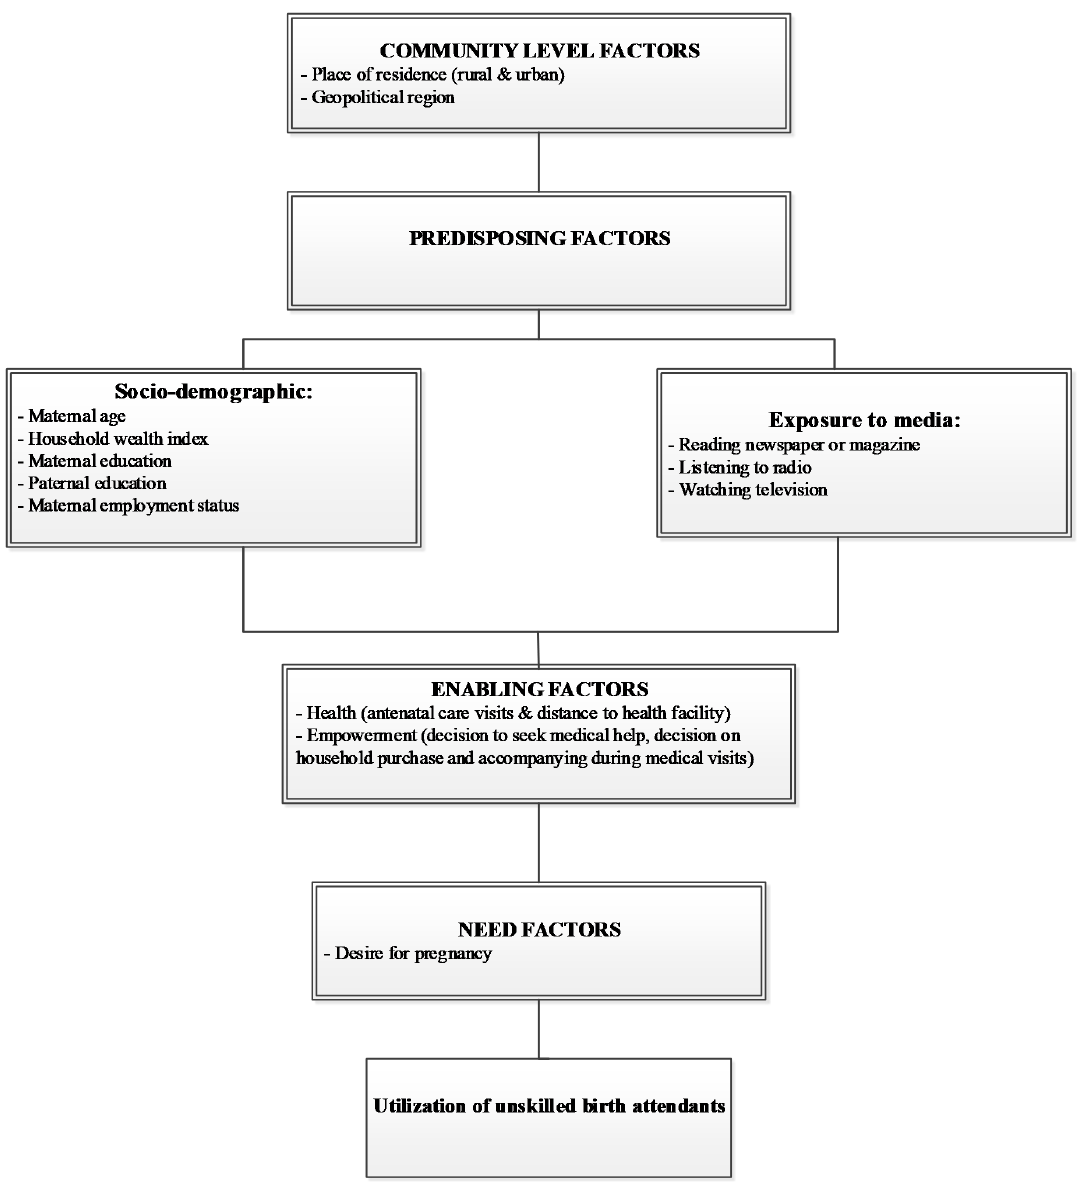
Figure 1. The conceptual model for the use of unskilled birth attendants in Nigeria, modified from Anderson’s health service utilization model [36].